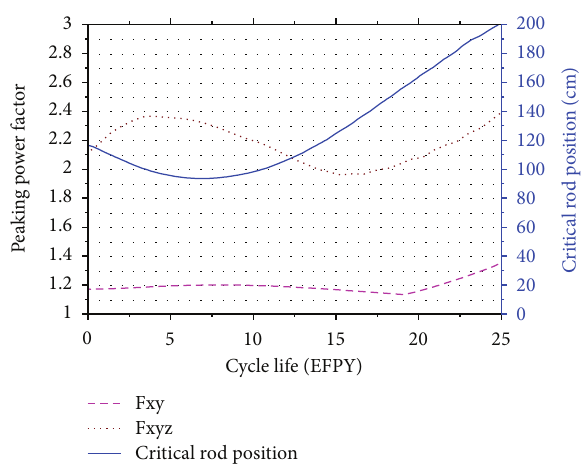
Figure 13: Critical rod position and power peaking factor versus cycle